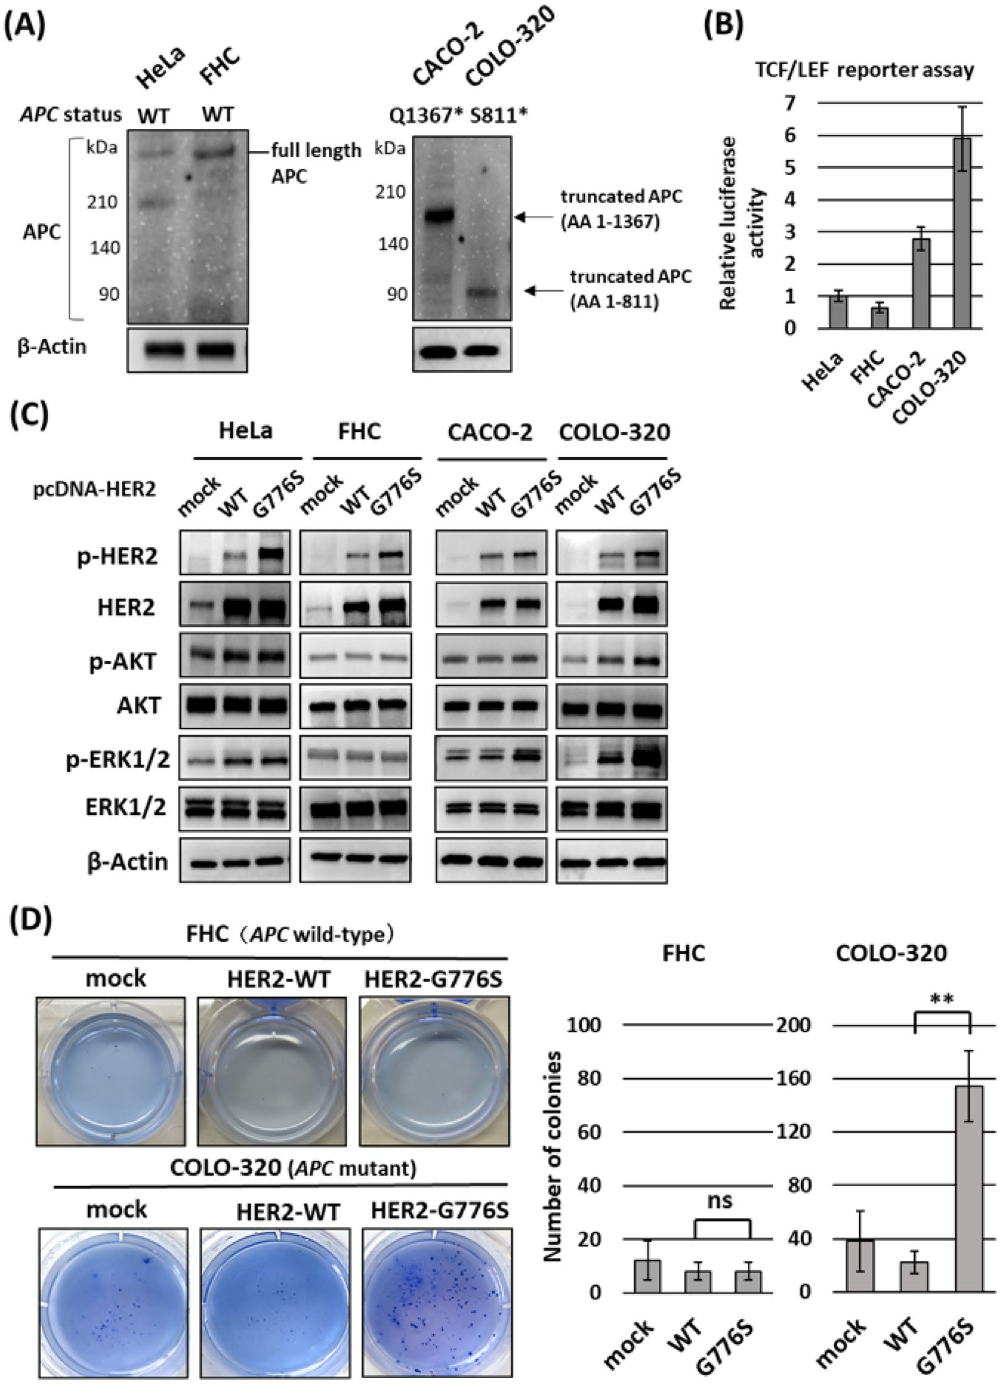
Figure 3. Effects of HER2 G776S mutation on the HER2 signaling pathway and anchorage-independent growth in several cell lines. ( A ) Detection of APC proteins in each cell by Western blotting. Full-length APC was detected with APC antibody (#2504, Cell Signaling Technology), and truncated APC was detected with APC antibody (sc-9998, Santa Cruz Biotechnology) raised against the N-terminus of APC. ( B ) The activity of the Wnt/β-catenin signaling pathway measured using the TCF/LEF luciferase reporter assay. The assay was performed in triplicate and the results were standardized to the mean of the activity of HeLa cells. ( C ) Phosphorylation and expression of HER2 and the downstream signaling in WT HER2 - or HER2 G776S- transfected HeLa and colon cells (FHC, CACO-2 and COLO-320). ( D ) Soft agar colony-forming assays showing the effects of stable transfection with HER2 WT or HER2 G776S in FHC (WT APC ) and COLO-320 (mutant APC ) cells. The cells were seeded into six-well plates in triplicate, and the number of colonies per well was counted. ns, not significant. ** P < 0.01 HER2 WT vs HER2